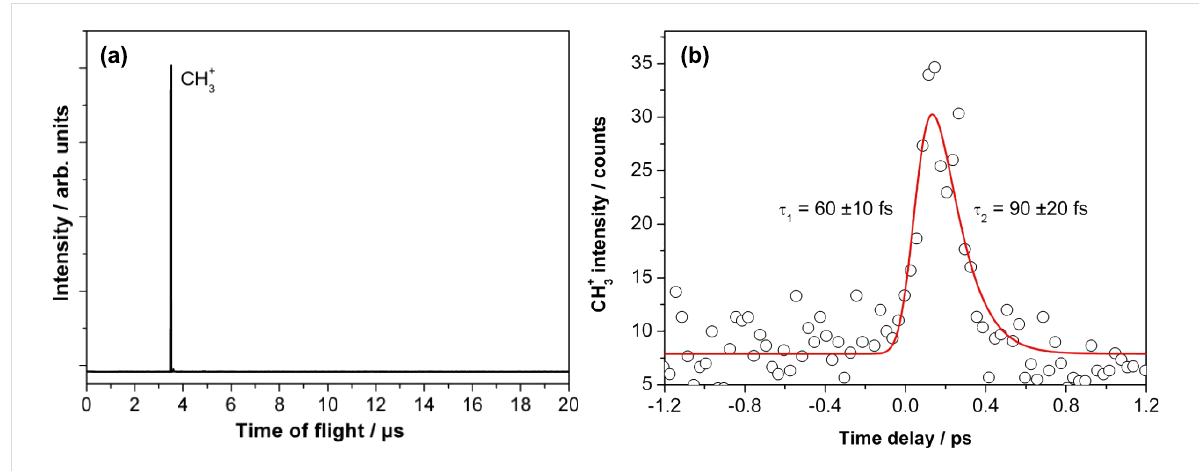
Figure 6: (a) Time-of-flight mass spectrum obtained from 0.25 ML methyl bromide adsorbed on a 10 ML Au film on Mo(100) at 140 fs pump–probe delay time. (b) Transient fs-photodissociation dynamics of CH 3 Br molecules adsorbed on Au(100)/Mo(100) recorded by monitoring the CH 3+ signal as a function of the pump–probe time delay. The surface temperature was 150 K. The solid line is the best fit of an exponential “rise and decay”-model to the experimental data, yielding the indicated time constants τ 1 and τ 2 . For the shown transient, four single transients were averaged to improve the signal-to-noise ratio. The transient was obtained with 2 mW/cm² pump (266 nm) and 200 mW/cm² probe (333 nm) laser power.